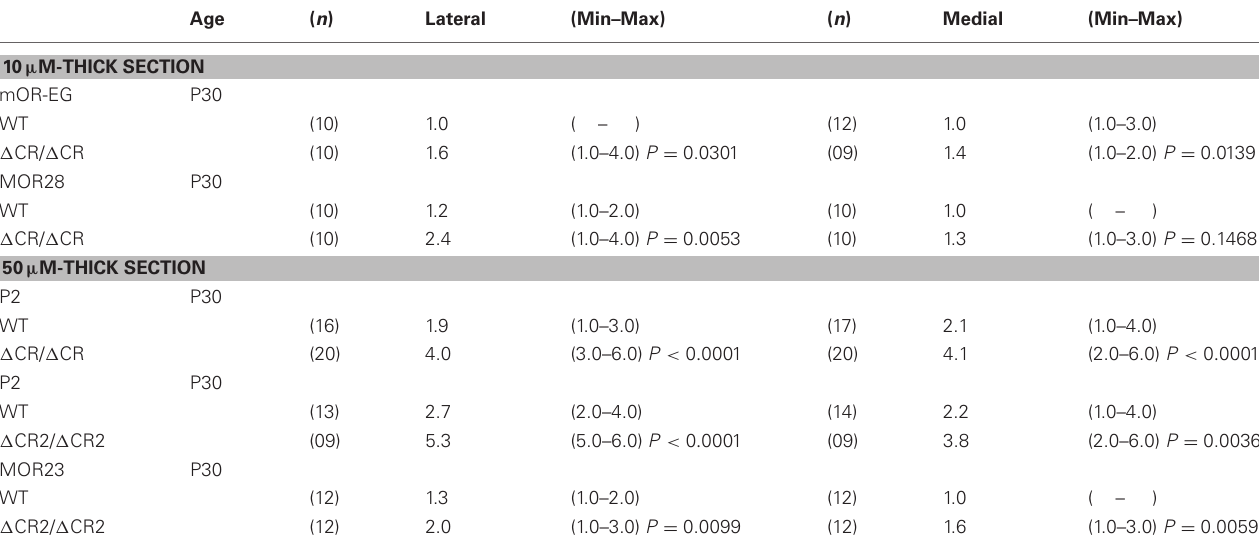
Table 1 | Number of glomeruli per half-bulb in sectional